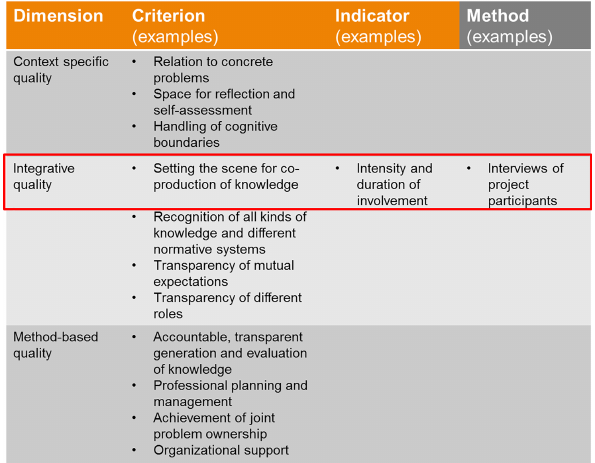
Figure 5. The example shows how the quality of outcome could be assessed by the indicator “usability” of new products and